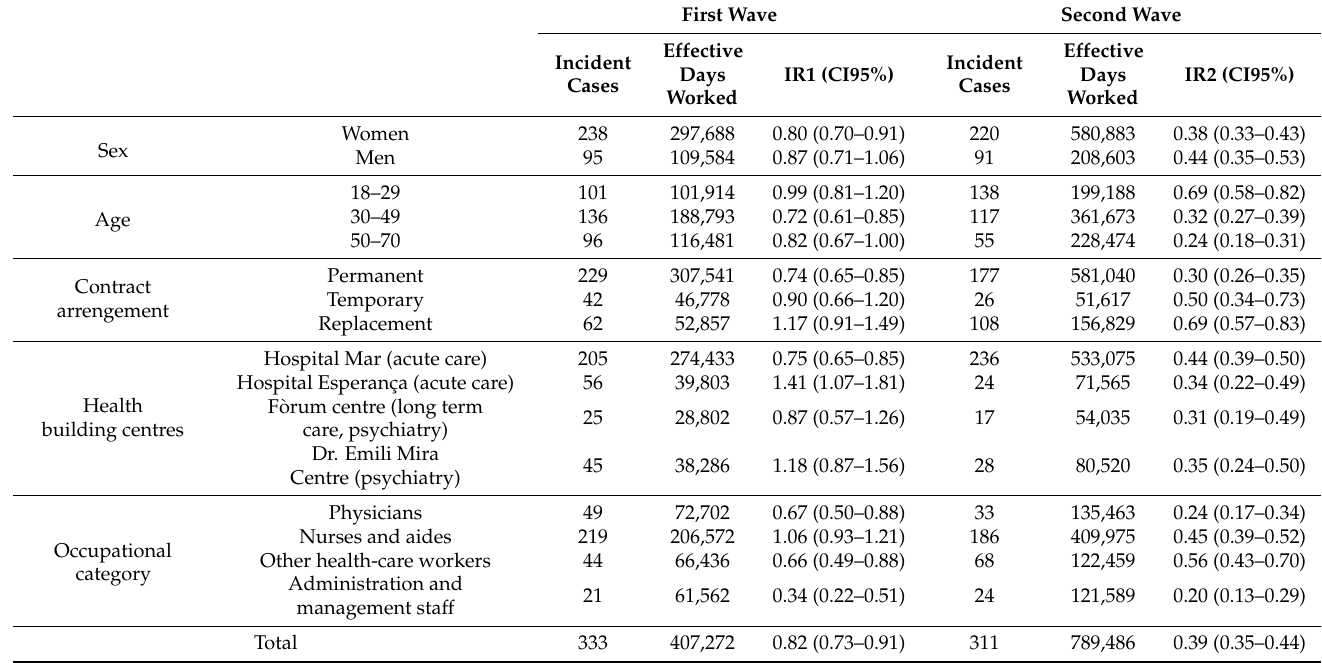
Table 1. Incident COVID-19 cases, effective working days, incidence rate (IR) per 1000 worker-days, during the first and second waves. By sex, age, contract arrangement, building centre, occupational category, and work shift. PSMar healthcare workers, 2020.